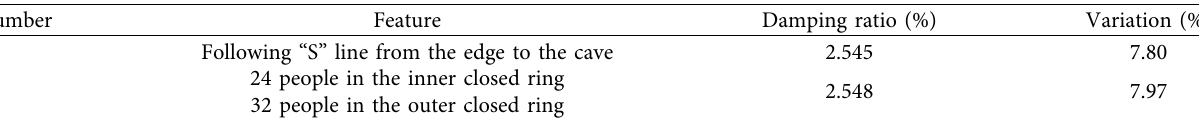
Figure 8: Measured FFT of the first vertical mode shape of the floor with ANPSD values. Table 3: The effect of walking feature on the structural dynamic